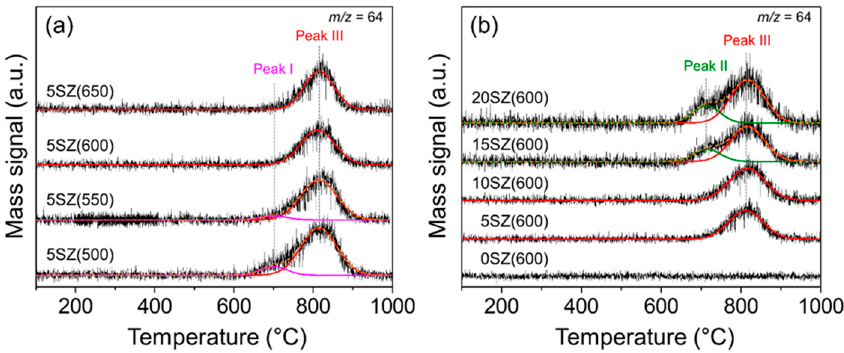
Figure 2. Evolution of ∙ SO 2 ( m/z = 64) in mass spectra as a function of decomposition temperature during TPDE experiment over ( a ) 5SZ( y ) and ( b ) x SZ(600) catalysts. Table 2. Results of TPDE, IPA-TPD, and Py-IR over x SZ( y ) catalysts.